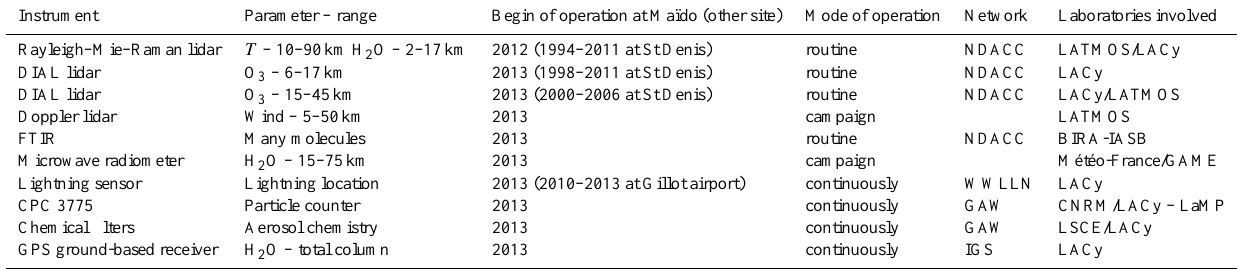
Table 1. List of instruments currently deployed at the Maïdo observatory. Data are available at https://opar.univ-reunion.fr/?lang=en. Instrument Parameter – range Begin of operation at Maïdo (other site) Mode of operation